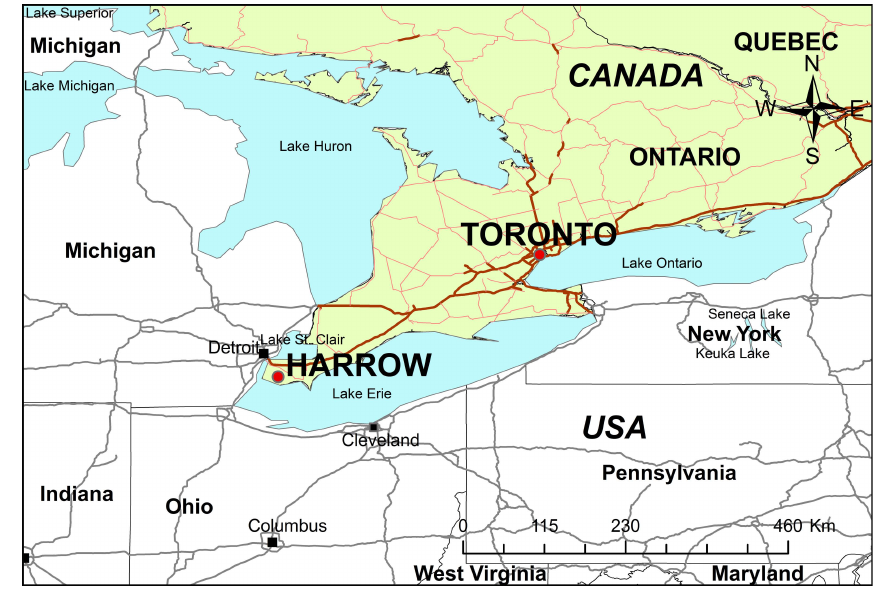
Fig. 1. Locations of monitoring sites during the SPORT (Toronto) and BAQS-Met (Harrow)